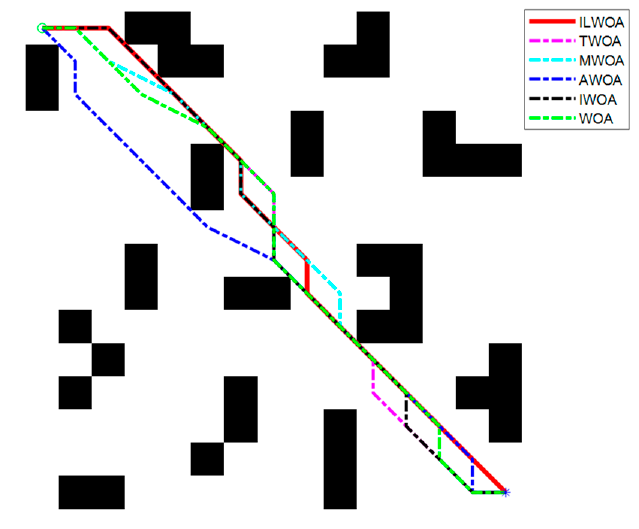
Figure 9. Robot path planning in Environment 1 scenarios.